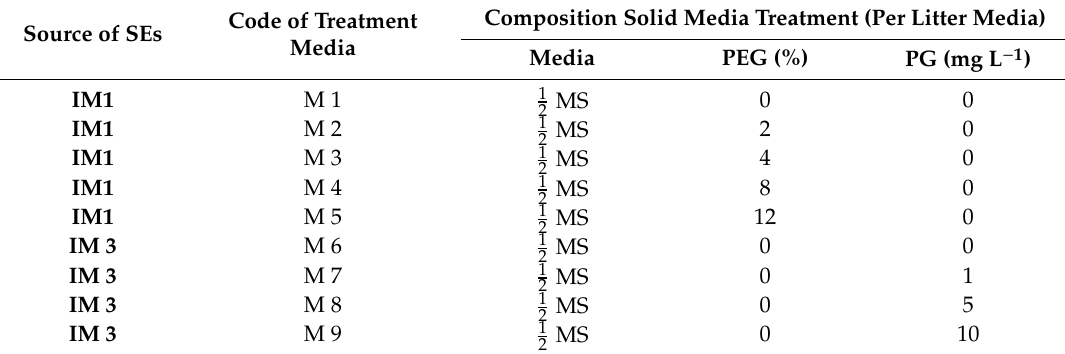
Table 9. The treatments composition during the maturation